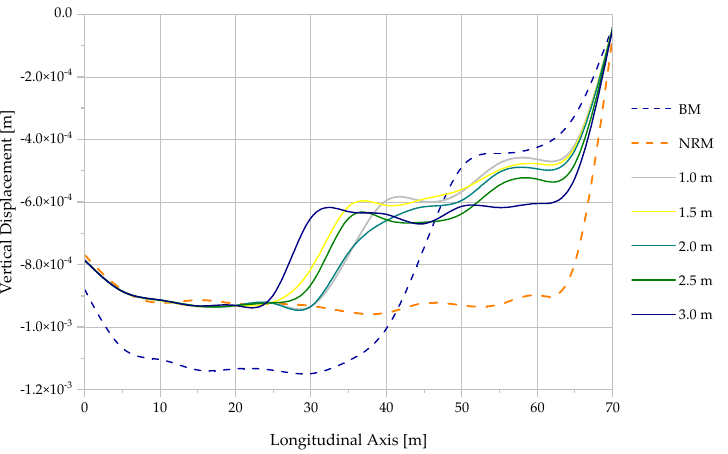
Figure 14. Vertical displacements when implementing the DHA90° with 38 and 30 BB sleepers per row in sets 1 and 2, respectively.